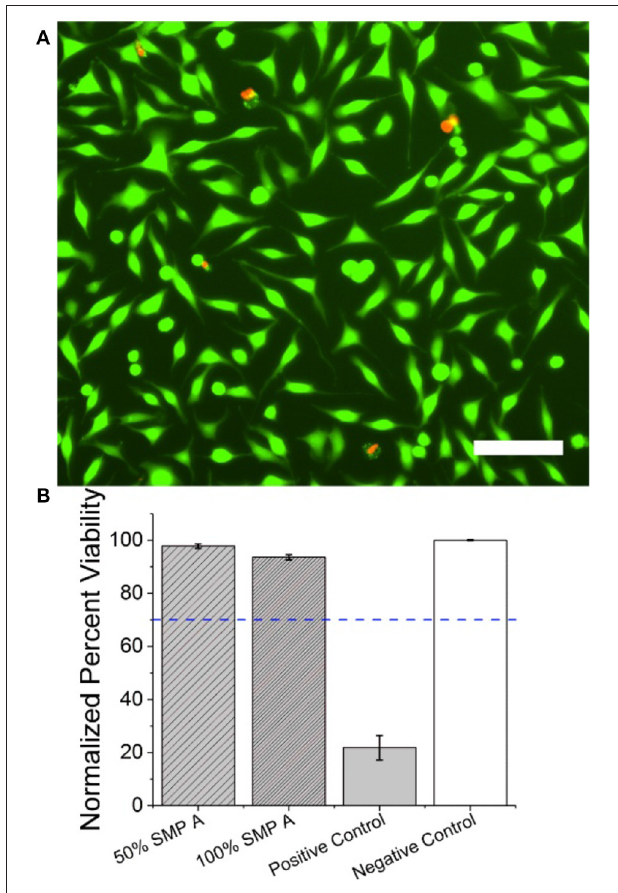
FIGURE 8 | SMP-A Cytotoxicity assays using NCTC fibroblasts (A) Fluorescent image of NCTC fibroblasts stained with CaAM (green) and EthD-1 (red). Green cells represent live cells while red cells represent apoptotic cells. Scale bar represents 100 µ m (B) Mean normalized cell viability percentage of SMP A at 50 and 100% concentrations, positive control, and negative control. Blue dotted line represents the 70% threshold based on ISO protocols ( ISO, 2008 ) needed to pass for non-cytotoxic